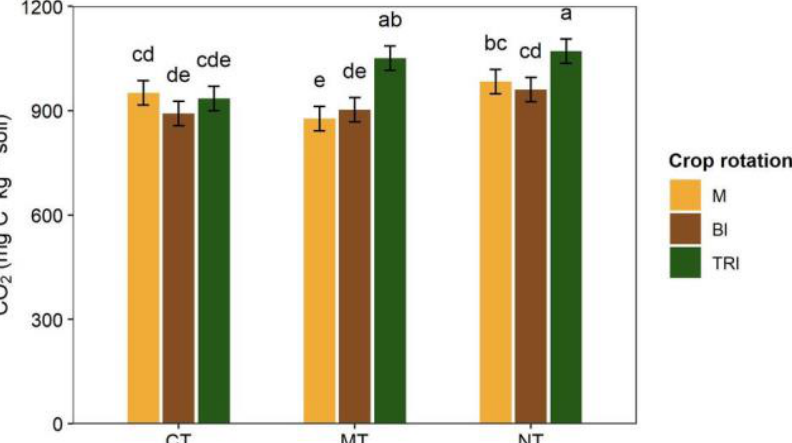
Figure 5. Effect of two-way interactions ‘Tillage × Rotation’ on total CO 2 released at 90-day incuba- tion. Tillage effect (No till: NT, moderate tillage: MT, and conventional tillage: CT) and Rotation effect (Monocropping: M, biennial: BI, and triennial: TRI). Data are averages ± standard errors. Different lowercase letters indicate significant differences between treatments ( p < 0.05).